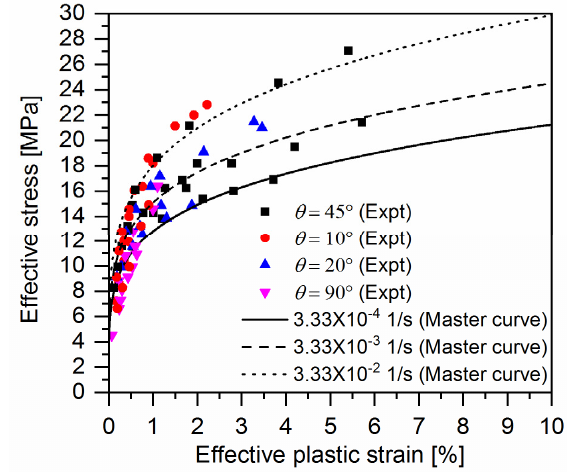
Figure 6. Effective stress ‐ effective plastic curves for quasi ‐ UD E ‐ glass/polypropylene composite at different strain rates. Table 2. Plastic parameters for quasi ‐ UD E ‐ glass/PP composite at three different strain rates. Strain Rate (1/s)